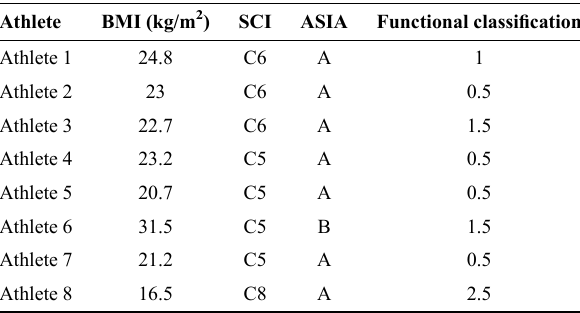
BMI = body mass index; SCI = spinal cord injury; ASIA = American spinal injury association impairment Scale, A= complete spinal cord injury, and B= complete and incomplete sensory-motor